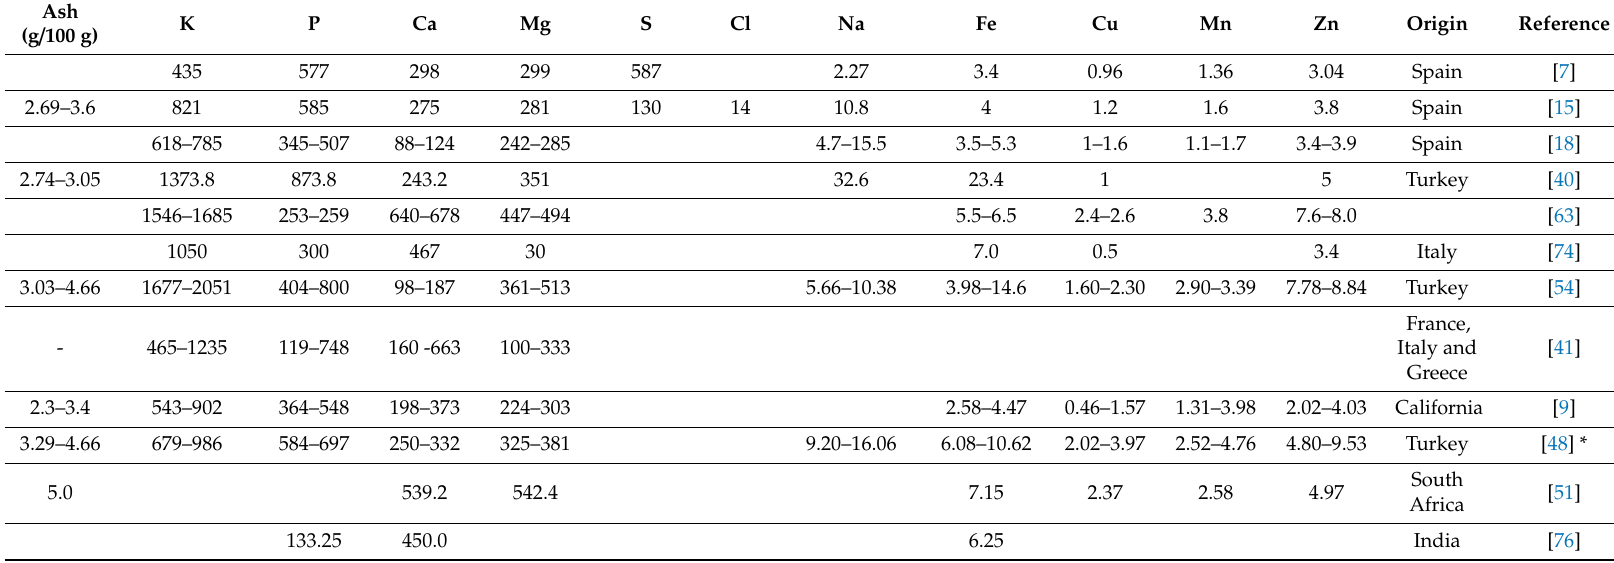
Table 2. Average value or range of main mineral elements (macro- and microminerals) found in almond kernel in the literature (mg / 100 g). Ash (g / 100